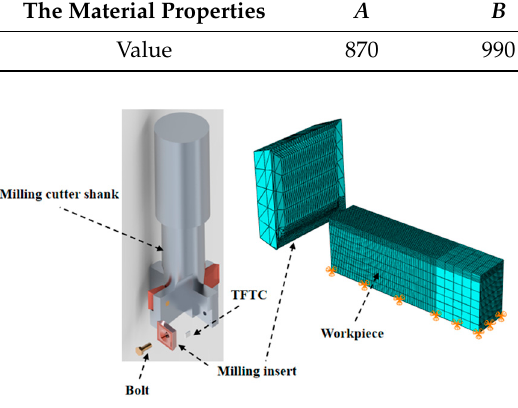
Table 1. JC model parameters for TC4 material.